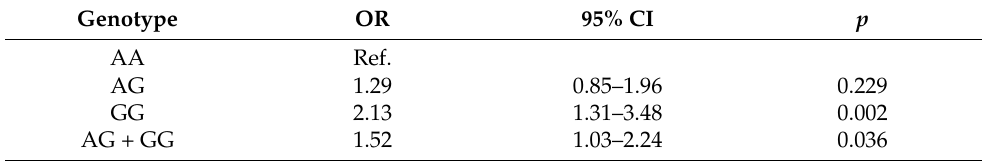
Table 4. NSCL/P risk and rs560426 polymorphism in ABCA4